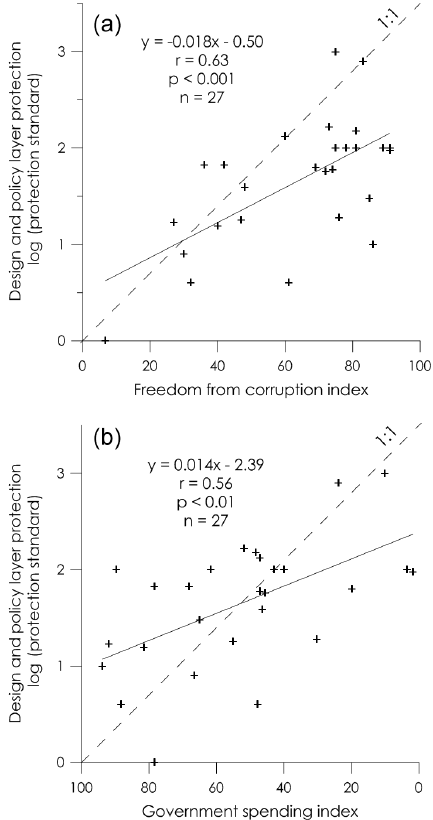
Figure 6. Examples of correlation of flood protection standards, as from our design and policy layer, with economic and policy indexes: (a) with the “government spending” index (note that the axis is reversed, because a 100 value of the index indicates min- imum government spending, and conversely), and (b) with the “freedom from corruption” index (The Heritage Foundation, 2014 (http://www.heritage.org/index/book/methodology); and references therein). For clarity, more freedom from corruption and more gov- ernment spending correspond to higher flood protection